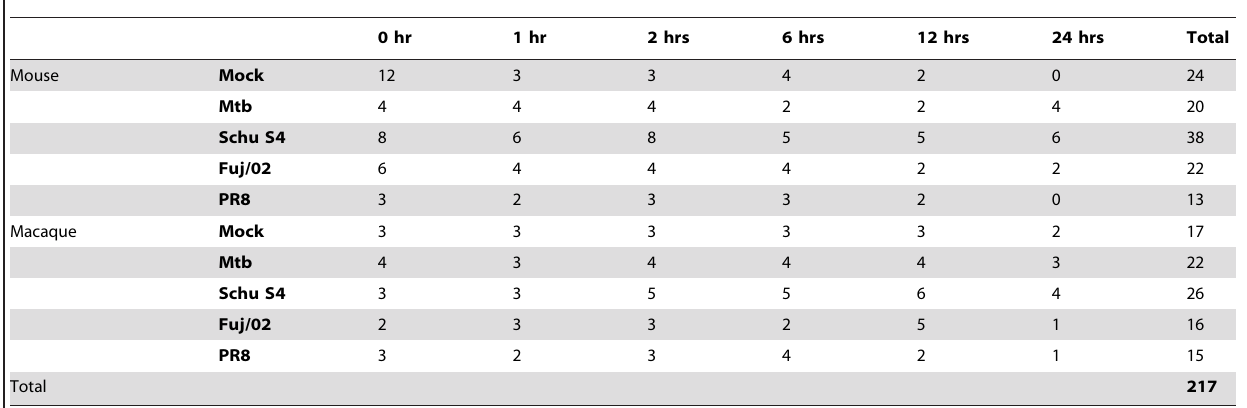
Table 1. Number of arrays used in the analysis.